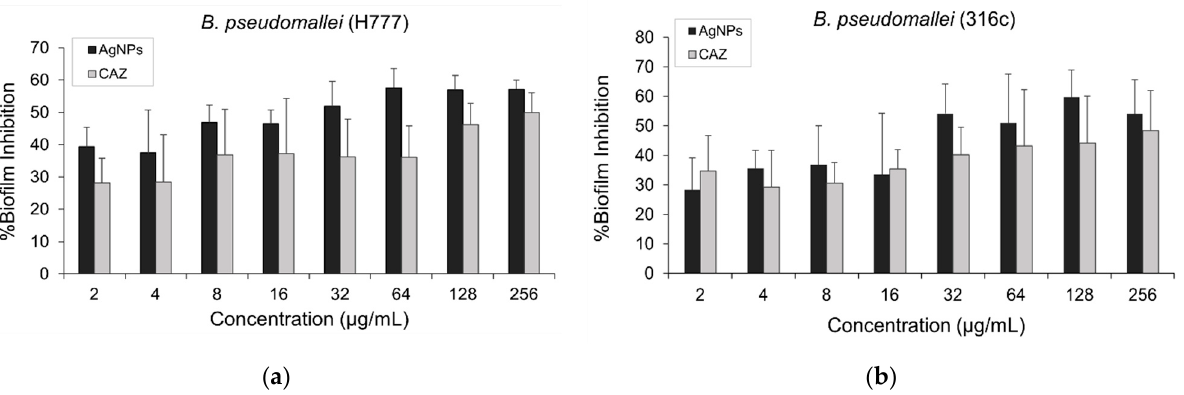
Figure 6. The effect of AgNPs and CAZ on inhibition of established biofilm against both CAZ-resistant strains: ( a ) B. pseudomallei (H777); ( b ) and 316c. Data are represented in mean ± SD from at least two independent experiments ( n = 5).